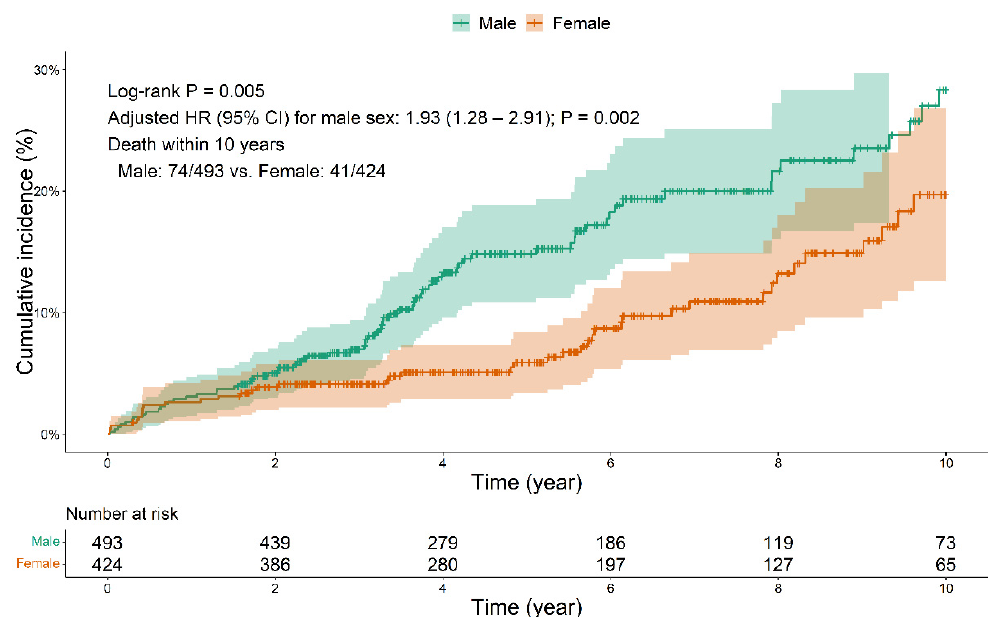
Figure 2. Ten-year mortality after surgical aortic valve replacement according to sex. HR, hazard ratio; CI, confidence interval.